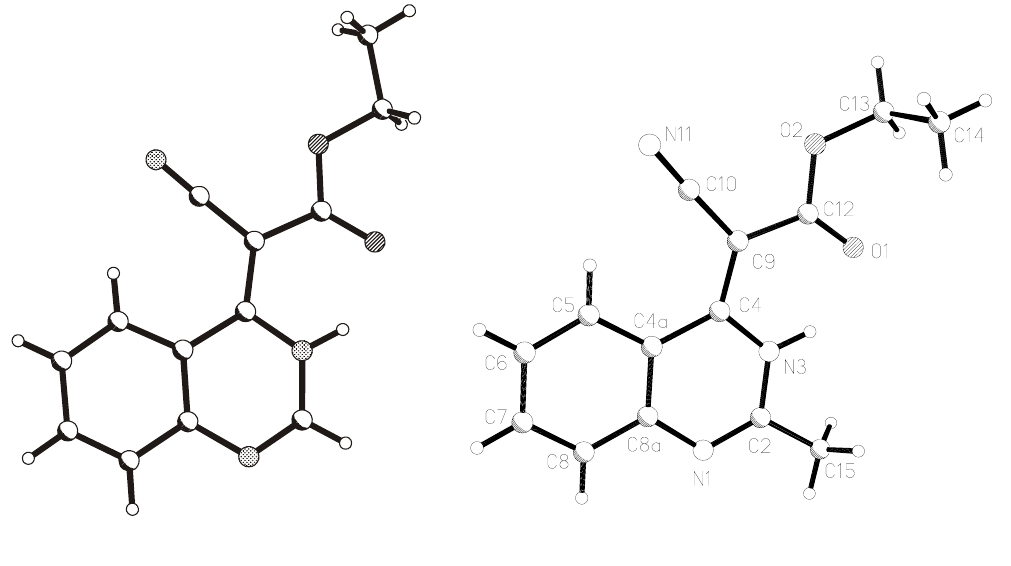
Figure 6. ORTEP plots of compounds 1 and 2 in crystal